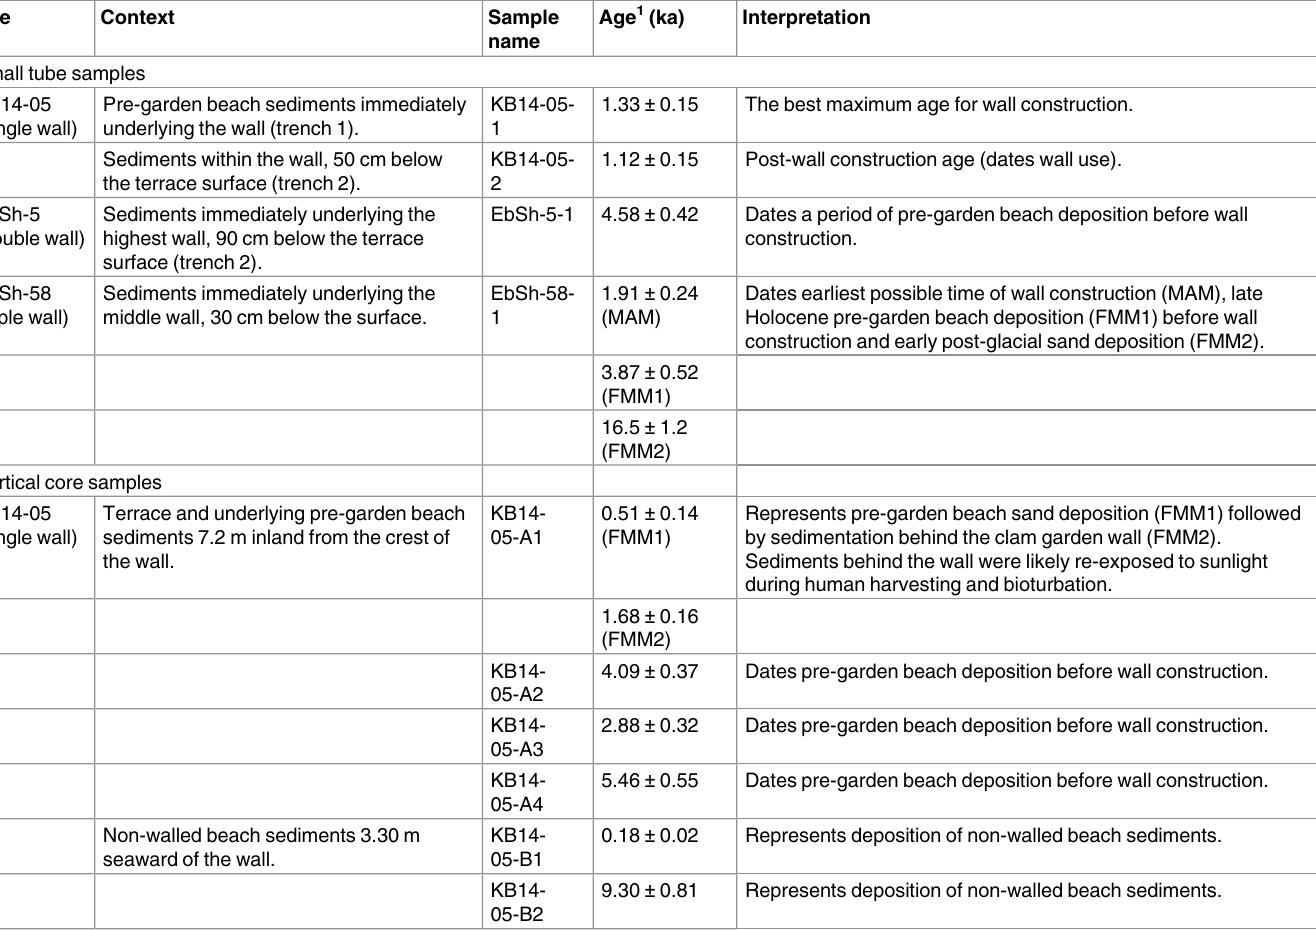
Table 2. Optical ages from three clam gardens on Quadra Island, BC (2014–2015). See Table 3 for more